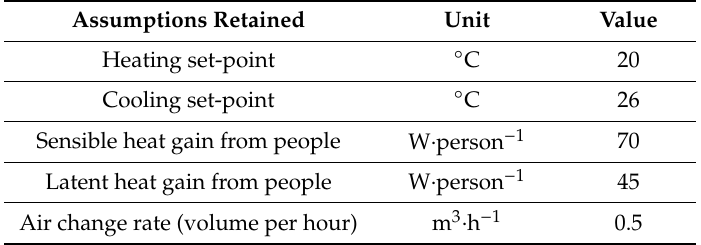
Table 3. EnergyPlus boundary condition data for the case study’s building.